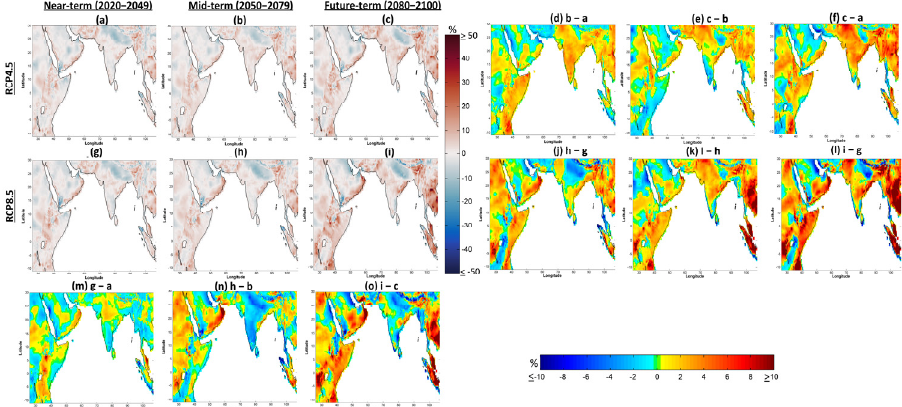
Figure 13. As in Figure 11, but for annual mean wind speed over land region of South Asian domain, and the percentage change is calculated based on projections of ACCESS1.0.